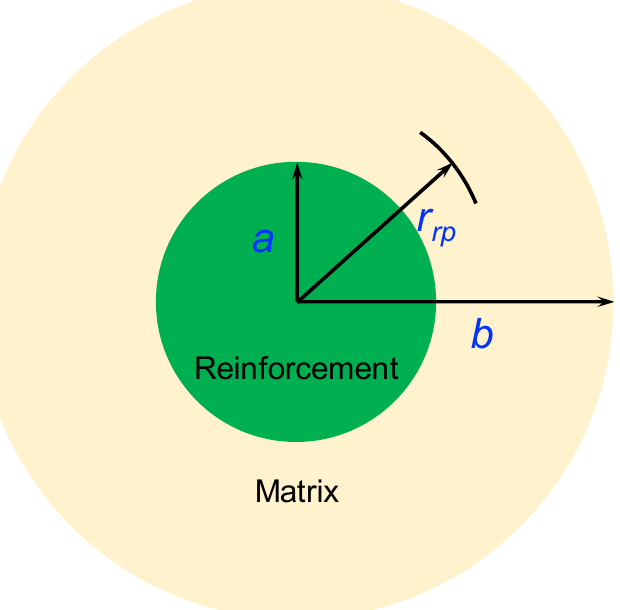
Figure 8. Schematic illustration of the representative volume element in the reinforcement/matrix composite.